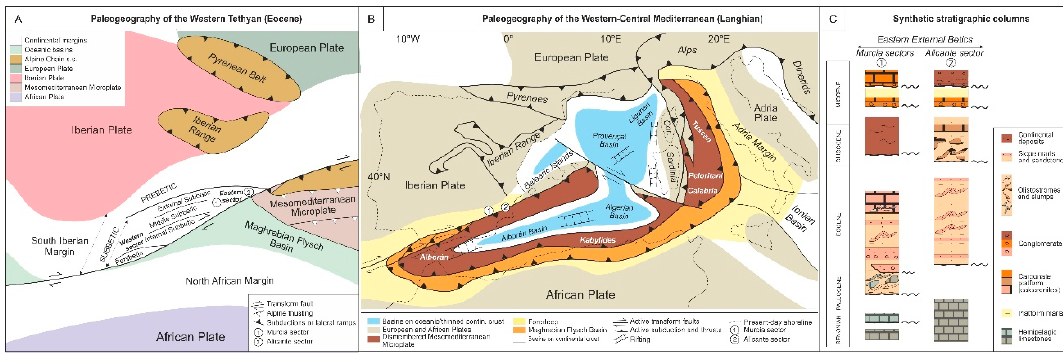
Figure 12. General geodynamic framework of the eastern EBZ in the context of the western peri-Mediterranean alpine chains. ( A ) geodynamic interpretation of the western Tethys during the Eocene (after Reference [19], modified), ( B ) geodynamic framework of the central-western Mediterranean area during the Miocene (modified from Reference [20]), ( C ) synthetic columns of the Cenozoic Bains in the Murcia and Alicante sectors of the eastern EBZ (after Guerrera et al. [19], modified)